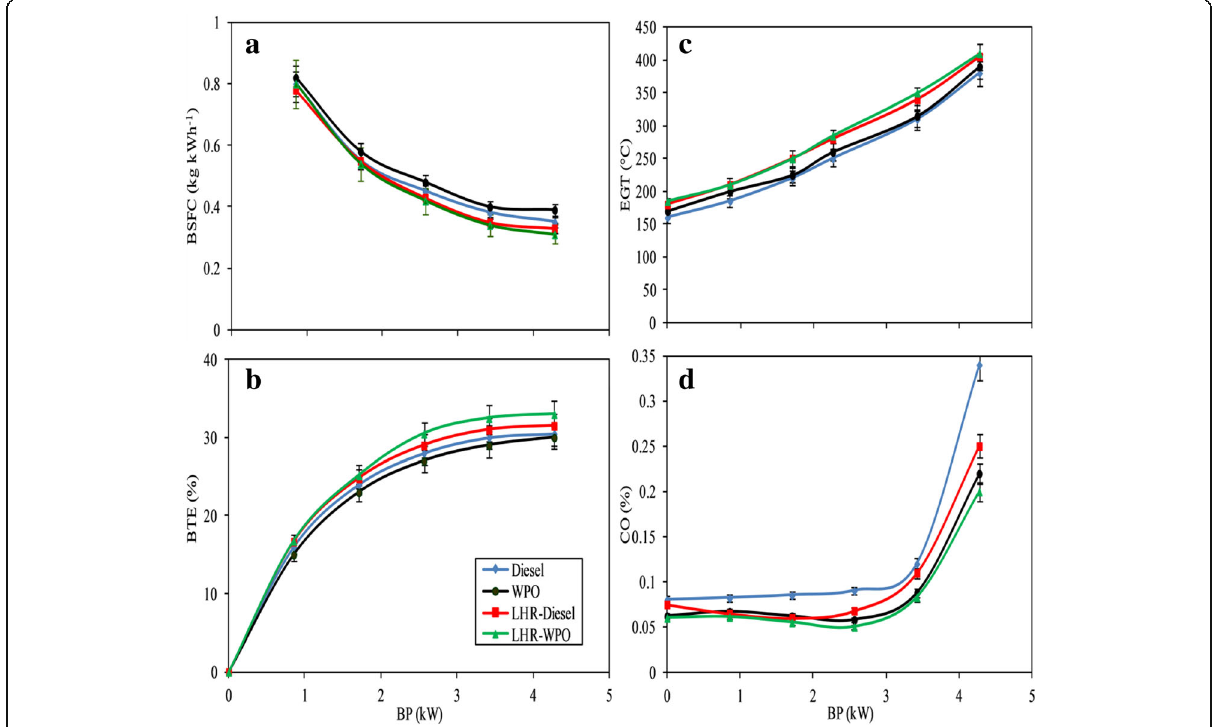
Fig. 2 Performance evaluation as a function of BP for all test fuels on coated and uncoated engines ( a ) BSFC, ( b ) BTE, ( c ) EGT and ( d)